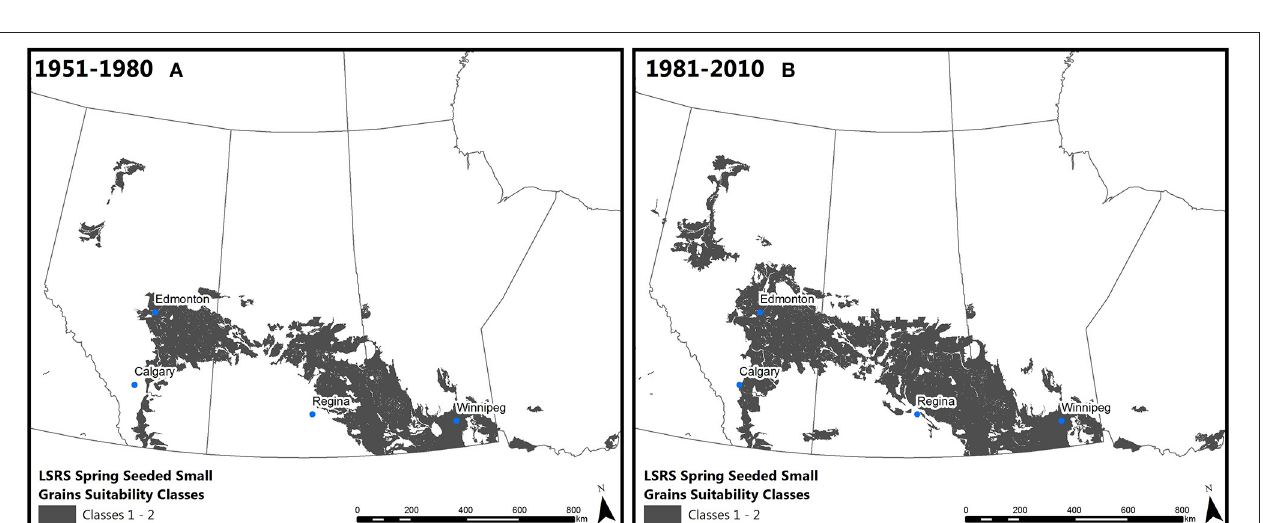
FIGURE 5 | National-scale map of land suitability classes for canola based on dominant soil types and the period 1981 to 2010. Highest suitability classes exist in Prince Edward Island (Charlottetown), in southern Quebec and Ontario and along the northern agricultural region of the Prairie provinces. Lower suitability classes result elsewhere in the country due to aridity in parts of western Canada and cool temperature in the Atlantic region.